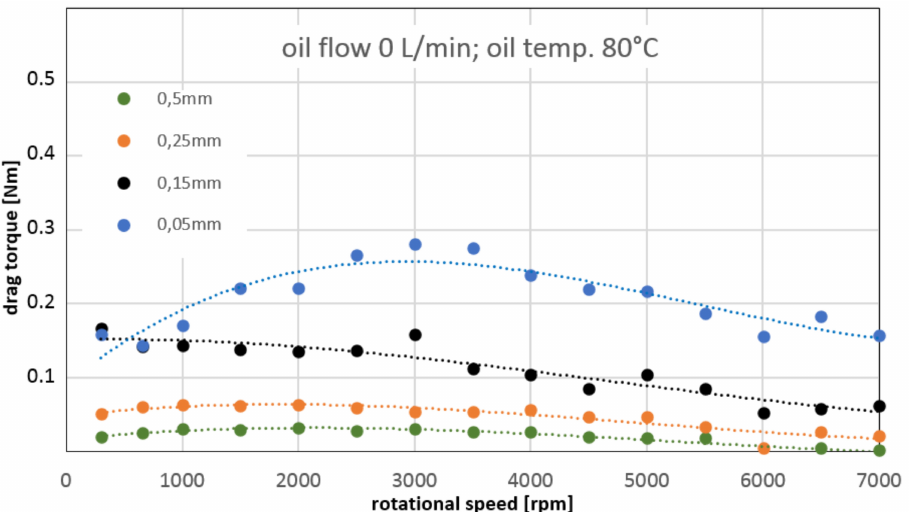
Figure 8. Influence of gap between plates on drag torque characteristics when no oil is